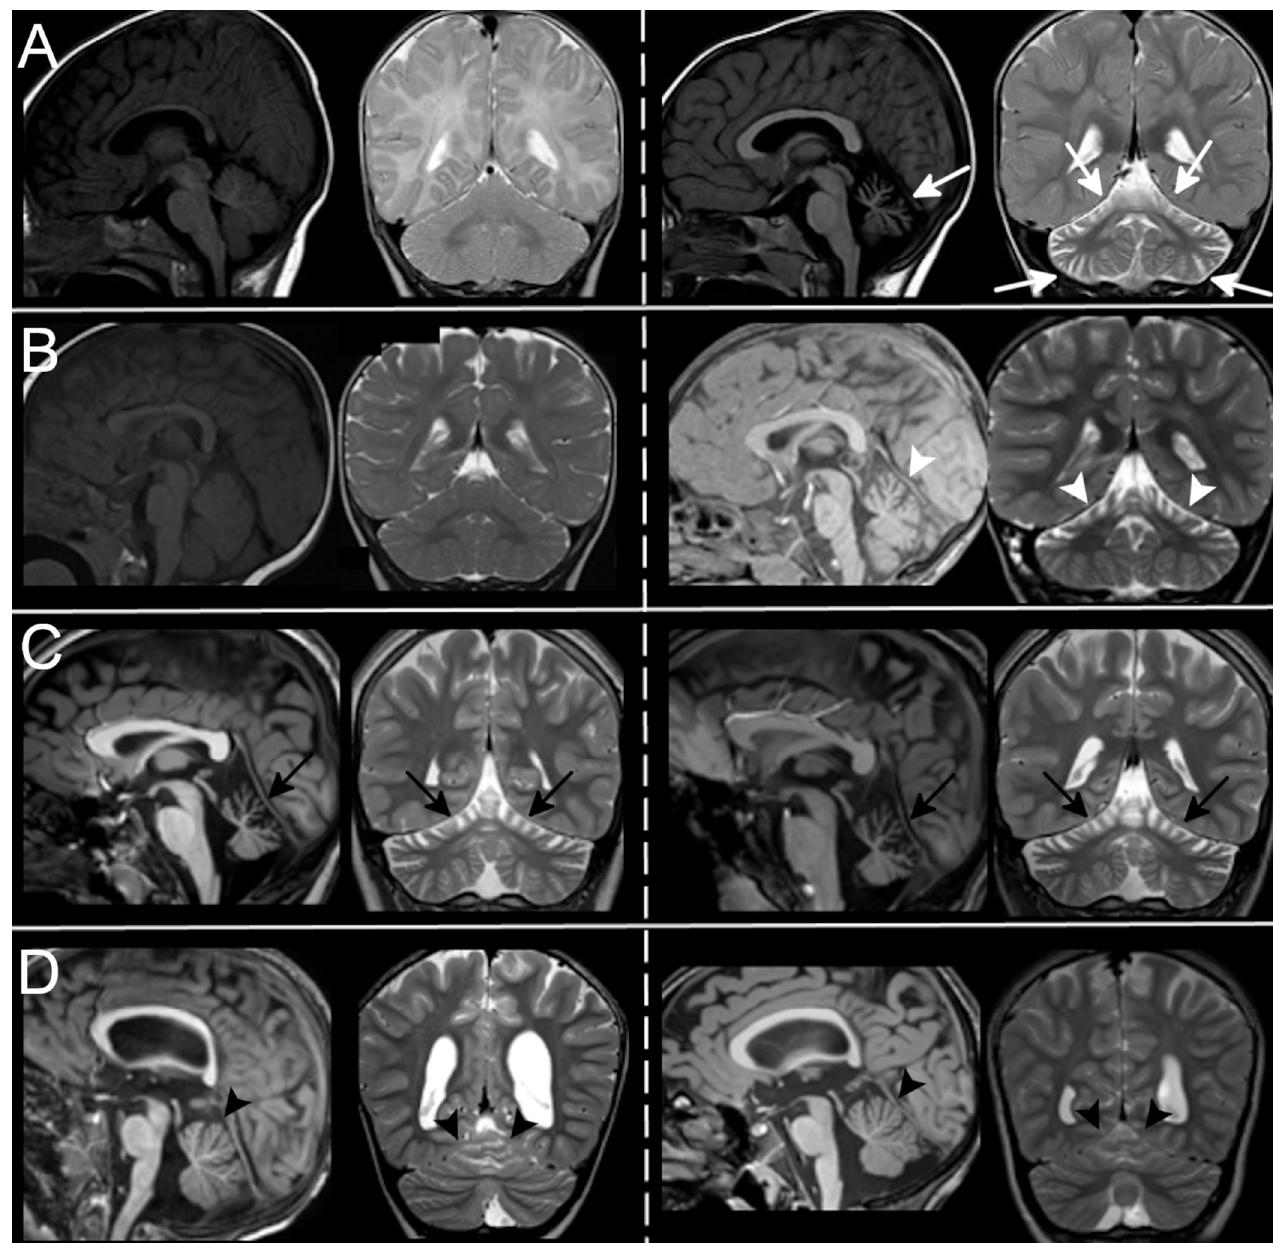
and FLAIR sections. The inferior part of the cerebellum is not atrophic and looks normal.